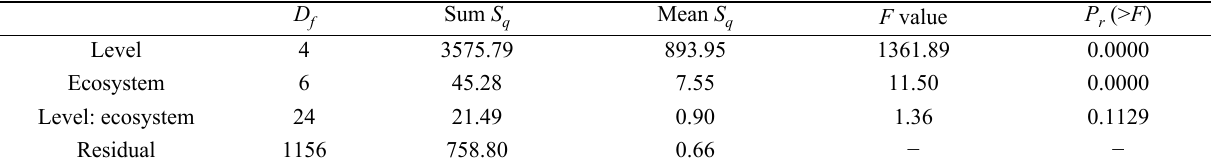
Fig. 5 Network structure of six simulated hunter-gatherer metapopulations visualized as hierarchical modular networks using the branching statistics from Fig. 4. In each simulated metapopulation the nodes in the networks are families ( ) linked by n = 256 multiple levels of interaction to form the subpopulations of the greater metapopulation. Fusion-fusion dynamics occur at multiple levels of the hierarchy as individuals, families, and bands move, interact, aggregate, and disperse at various timescales. The frequency of local interactions forms the modularity of the subpopulations, which vary in number. Each family exists in a small- world of dense local interactions, but is connected to the larger network by sparse global interactions. As a result, all families are connected to all others by short path lengths that extend across the entire metapopulation (generated using the EcoNetGen package in R [79] Table 4 ANOVA table of social group size by organizational level and ecosystem.